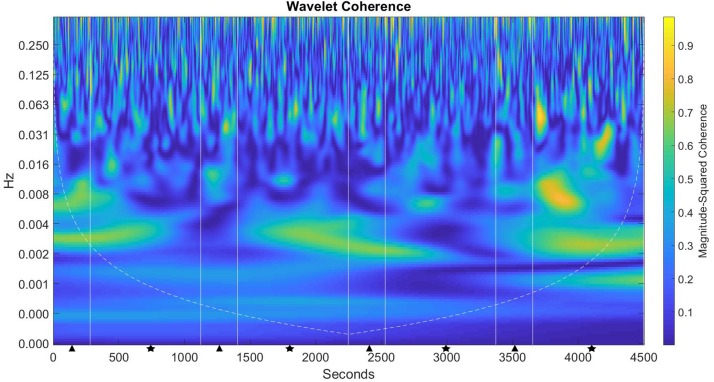
Magnitude-squared coherence plot for the ECM group. The left axis is the frequency of coherent activity in Hz; the bottom axis is time (s). Straight lines denote task cycles with decision (triangle) – monitoring (star), shaded contours represent areas of coherent activity of greater than 95% confidence.